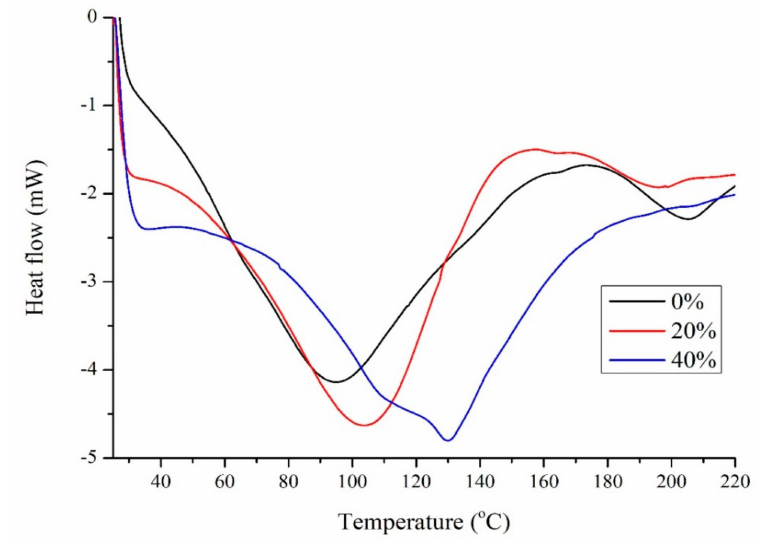
Figure 3. DSC for soy samples with 0%, 20%, and 40%